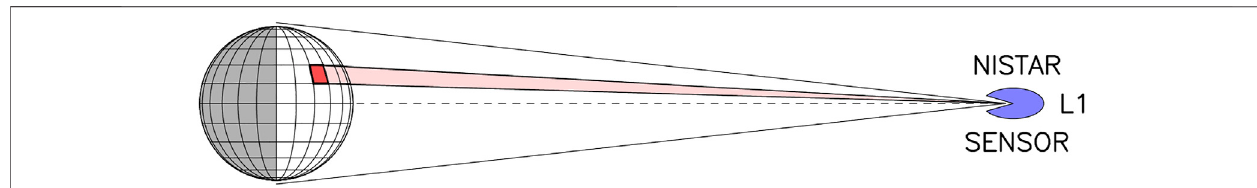
FIGURE 1 | Schematic diagram of NISTAR view of the Earth ’ s sunlit hemisphere from the Lissajous orbit around the solar Lagrangian L1 point. NISTAR views the entire sunlit hemisphere as a single pixel in 4 broadband channels, while companion instrument EPIC records spatially resolved images.